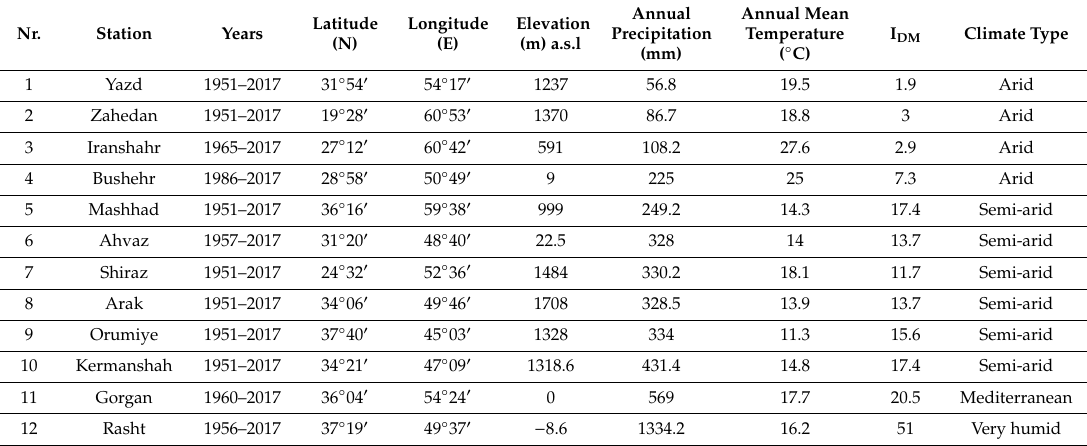
Table 1. The De Martonne Aridity Index (I DM ), annual precipitation, and mean temperature for the 12 synoptic stations over long